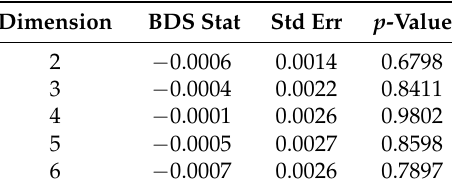
Table A5. BDS test for ˆ ν t